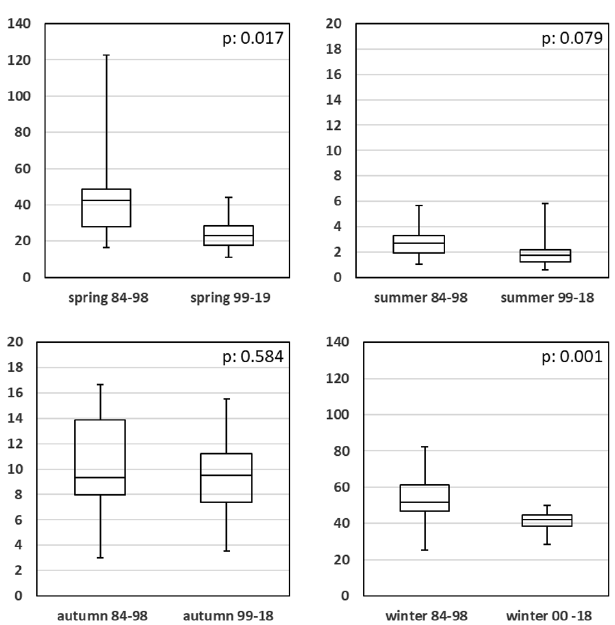
Figure 6. Seasonal comparison (box plots and t test p values) of dissolved inorganic nitrogen (DIN) concentrations (µmolL − 1 ) for high and low eutrophication periods. Detailed information is avail- able in Fig. 5b.